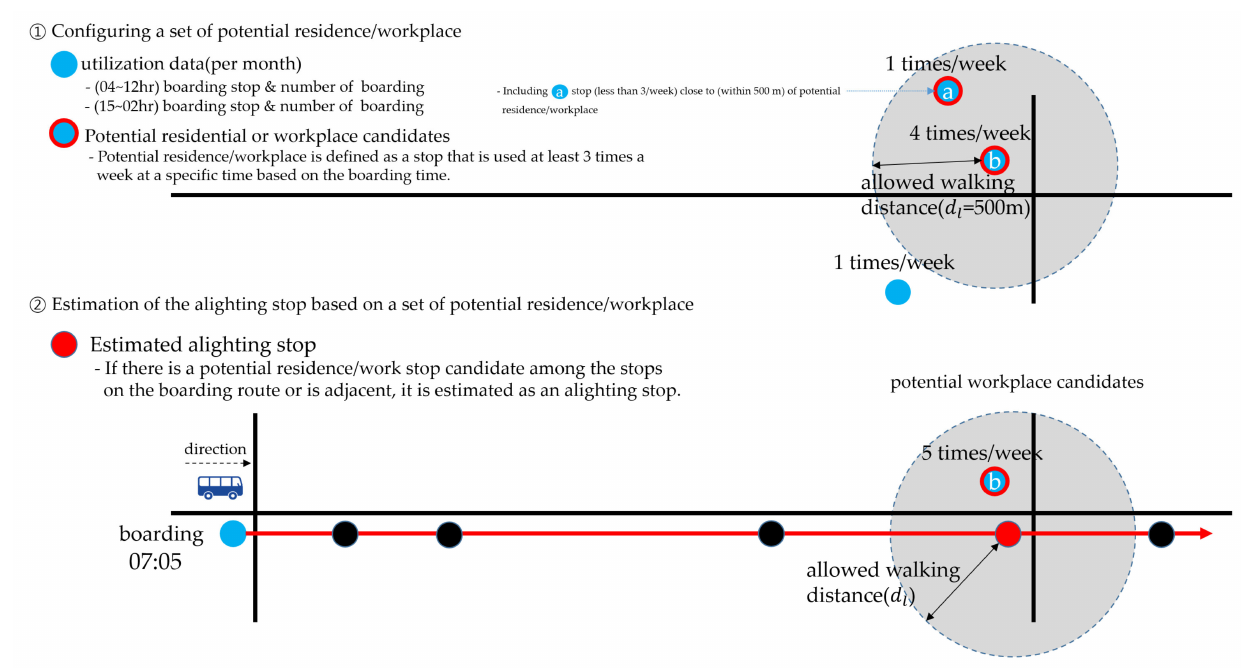
Figure 3. Method of estimating the alighting stop for non-continuous recurrent